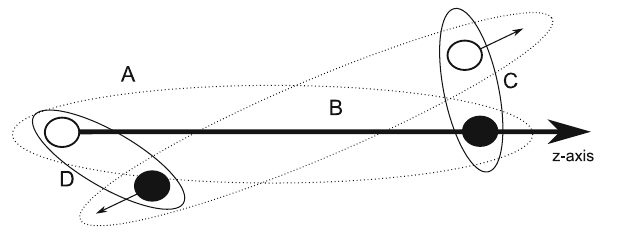
Fig. 2 Representationofrapidity-basedcolourreconnectionwherethe quark axis of one cluster is defined as the z-axis in respect to which the rapidities of the constituents from the possible reconnection candidate are calculated. ( A ) and ( B ) are the original clusters. ( C ) and ( D ) would be the new clusters after the reconnection